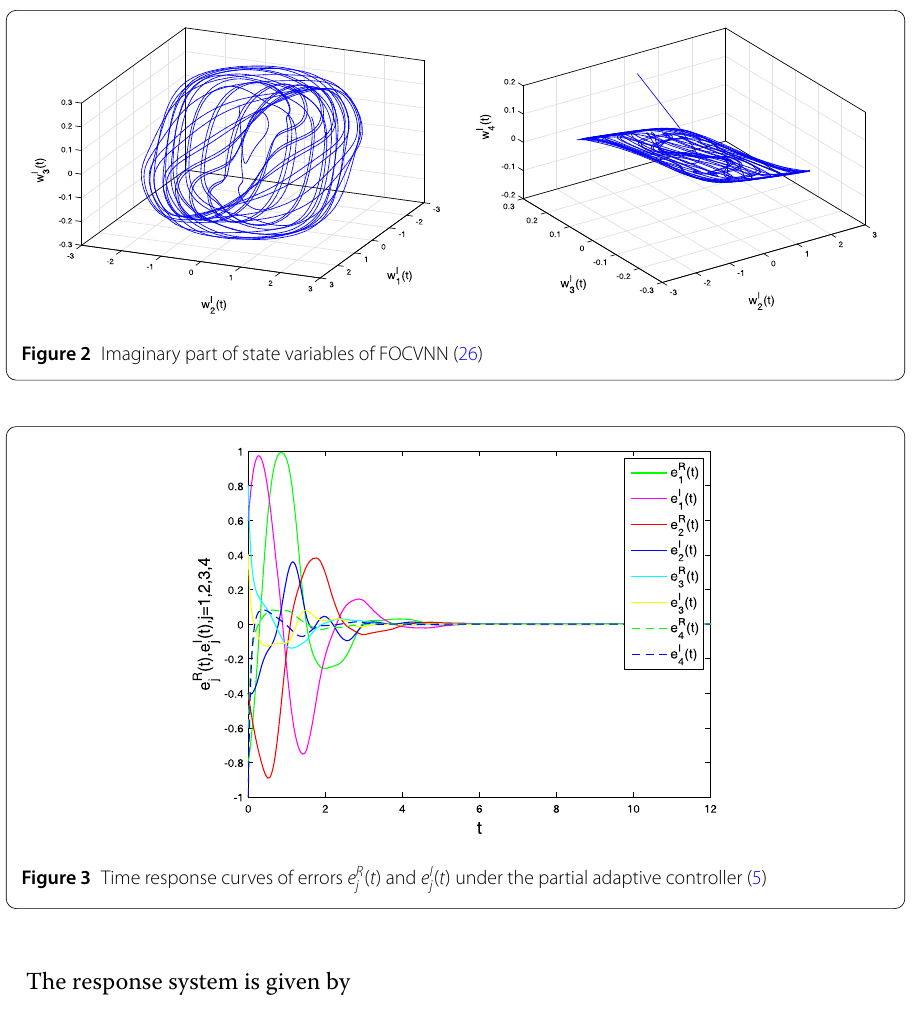
Figure 3 Time response curves of errors e R